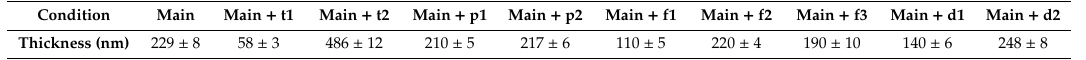
Table 3. Thickness of the styrene-based coating under di ff erent experimental